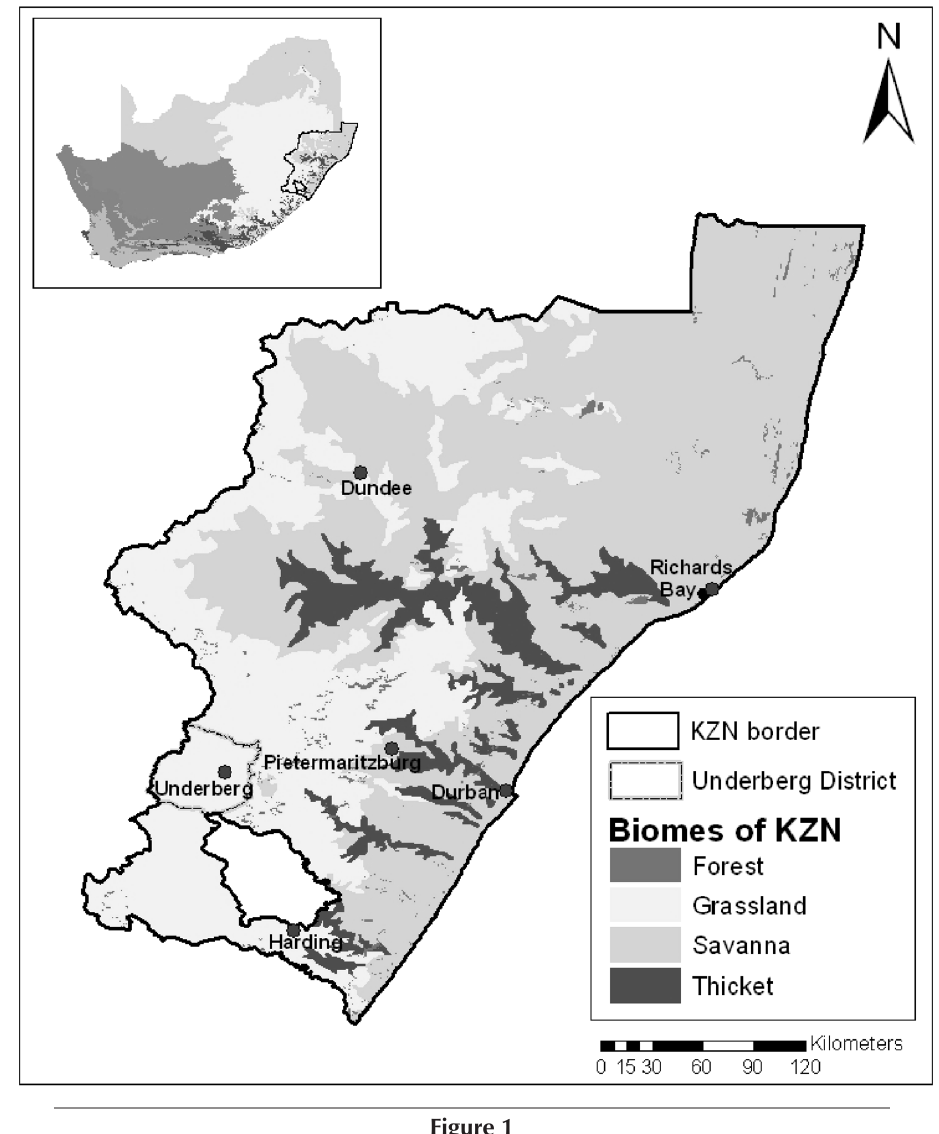
The position of the Underberg Magisterial District in KwaZulu-Natal in relation to the grassland